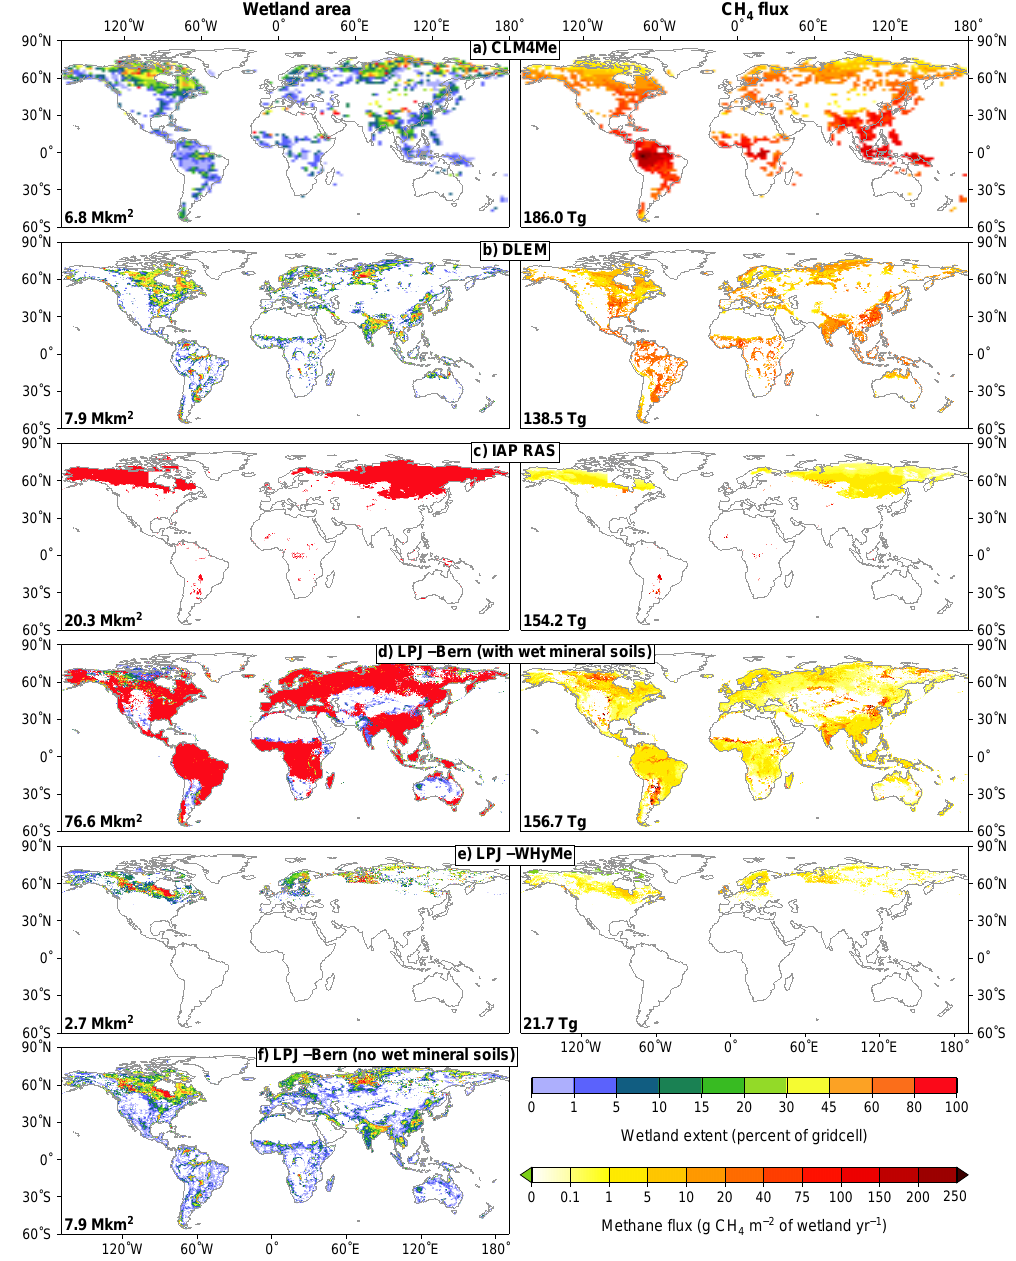
Fig. 8. Mean annual maximum extent of prescribed or simulated wetland area and mean annual CH 4 flux for Experiment 1-equil over the 1901–1931 period. Global total wetland area (Mkm 2 =Million km 2 ) and CH 4 emissions (Tg=Tg CH 4 per year) have been added to each plot.